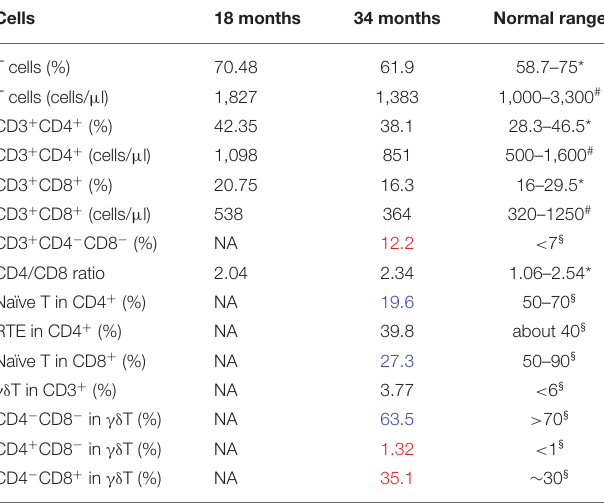
TABLE 1 | Immunophenotype of the